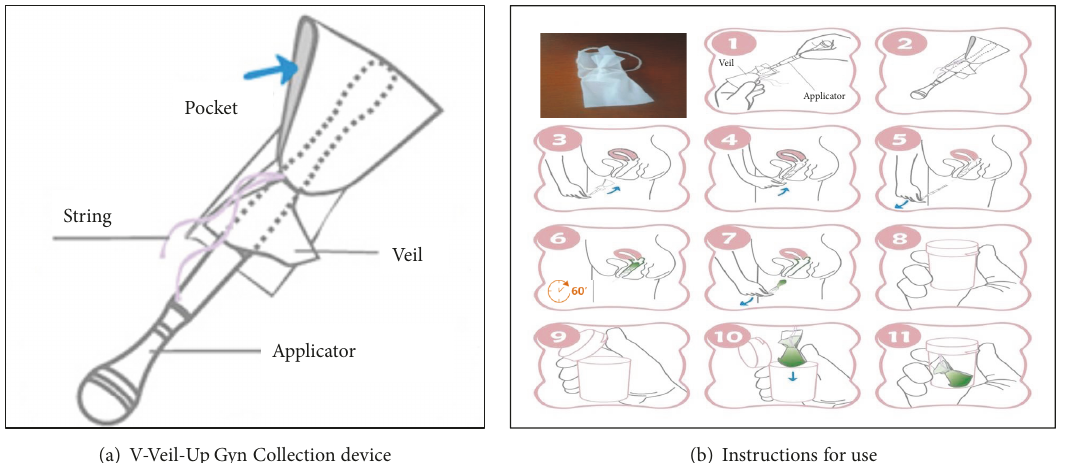
Figure 2: (a) V-Veil-Up Gyn Collection Device (V-Veil-Up Pharma Ltd.) . The V-Veil-Up Gyn Collection Device consists in a pocket (length: 75 mm, width: 45 mm, surface of contact: 6,75 cm 2 ) in non-woven hydrophilic polyethylene having a capacity of absorption of 1.4 g of liquid, associated with a thread in cotton yarn (nm 16/4) and a transparent applicator (length: 120 mm, diameter: 10.8 mm) in